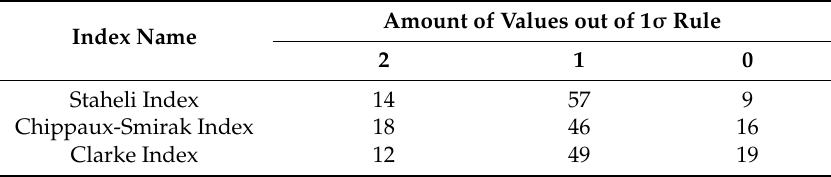
Table 2. Number of cases with the respective amount of values (2, 1 or 0) out of the one-sigma (1 σ ) rule in every calculated index from the dataset of a subject’s foot.